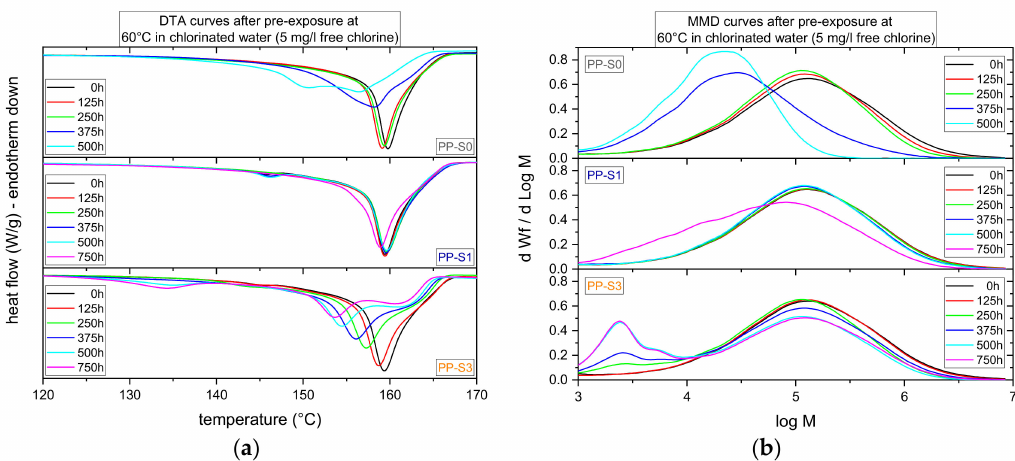
Figure 3. ( a ) Di ff erential thermal analysis (DTA) curves indicating the melting peaks in the second heating step and ( b ) molar mass distribution (MMD) curves for various exposure times of micro-sized specimens to chlorinated water (5 mg / L free chlorine) at 60 ◦ C for the three polypropylene (PP)